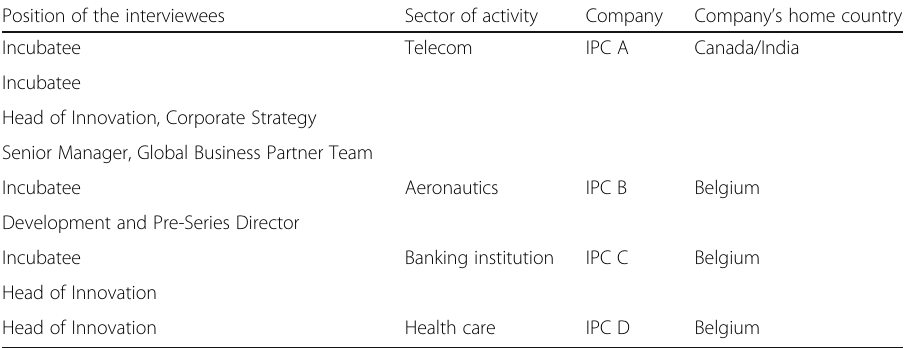
Table 2 Respondents and IPCs sampled Position of the